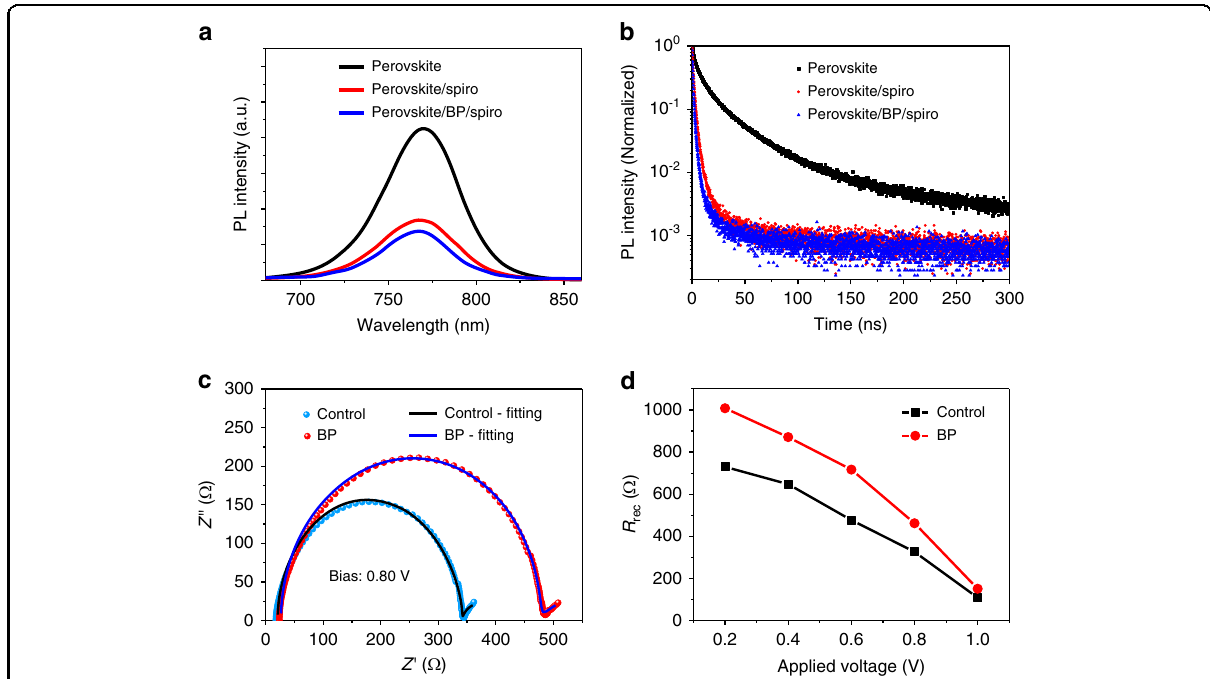
Fig. 3 Optoelectronic characteristics of the MAPbI 3 perovskite fi lms and devices. a , b Steady state ( a ) and time-resolved ( c ) PL spectra of three fi lms, including the perovskite, perovskite/spiro and perovskite/BP/spiro fi lms; the fi lms were deposited on quartz substrates. c Impedance spectra of the PSCs without (control) and with BP modi fi cation (2 coats) measured at a bias voltage of 0.80 V under light illumination of 100 mW cm − 2 . d Recombination resistance of PSCs derived from impedance spectra at different bias voltages under light illumination of 100 mW cm −